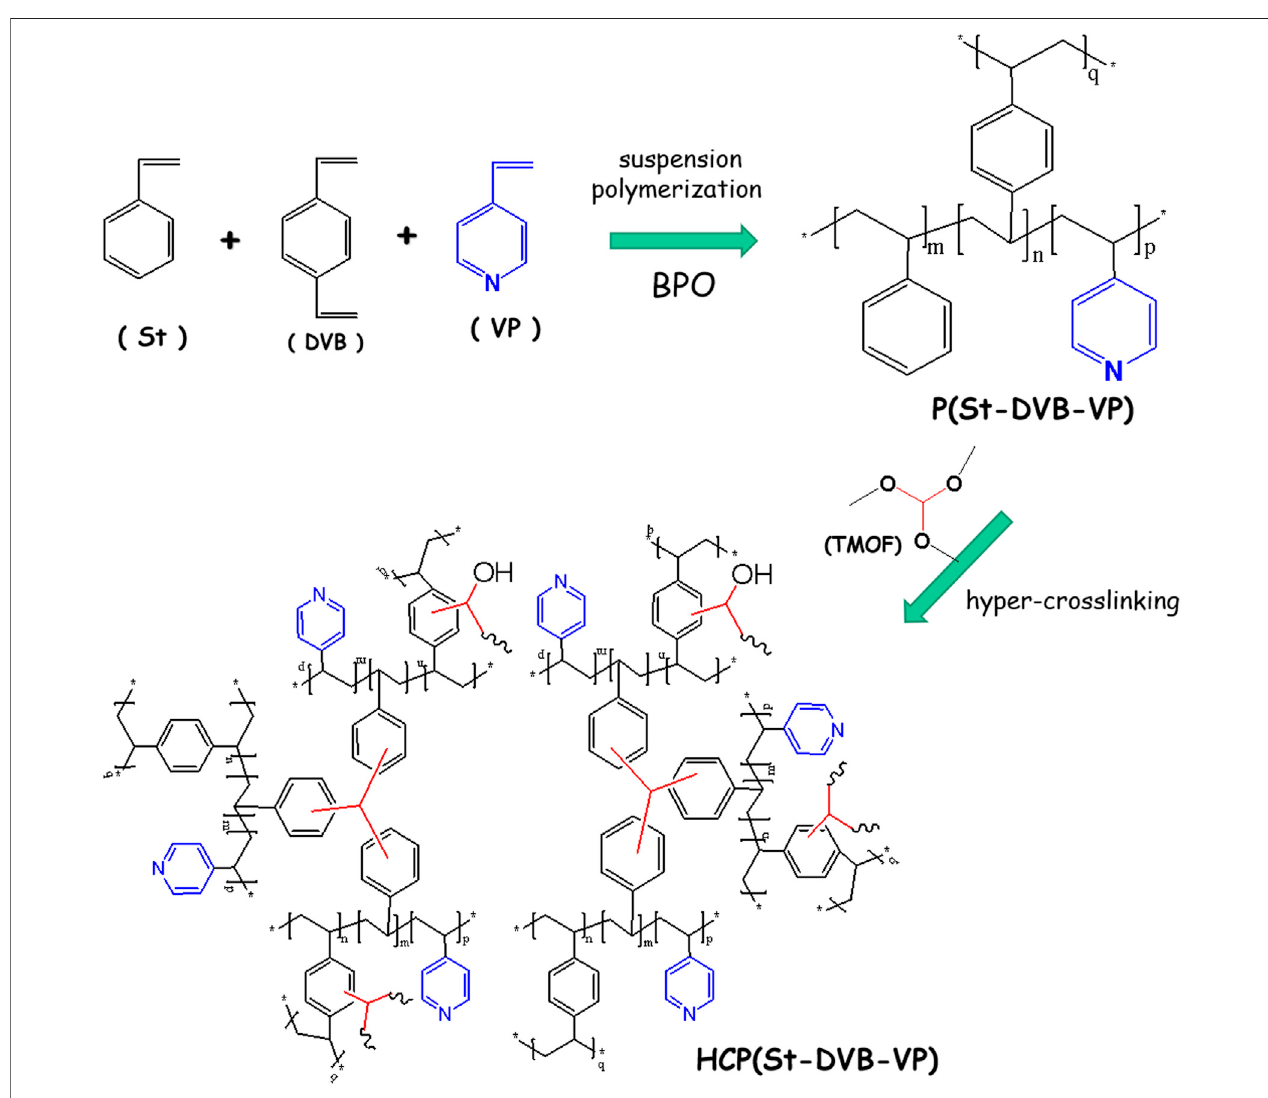
FIGURE 1 | Schematic diagram of the HCP(St-DVB-VMP) fabrication